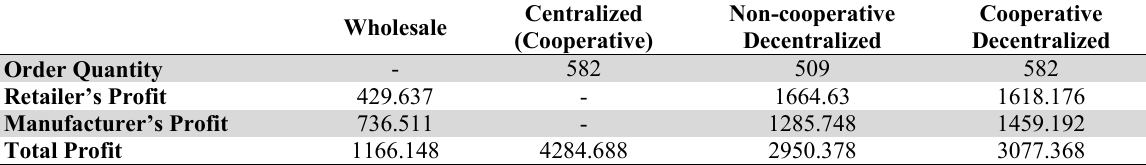
Cooperative Decentralized